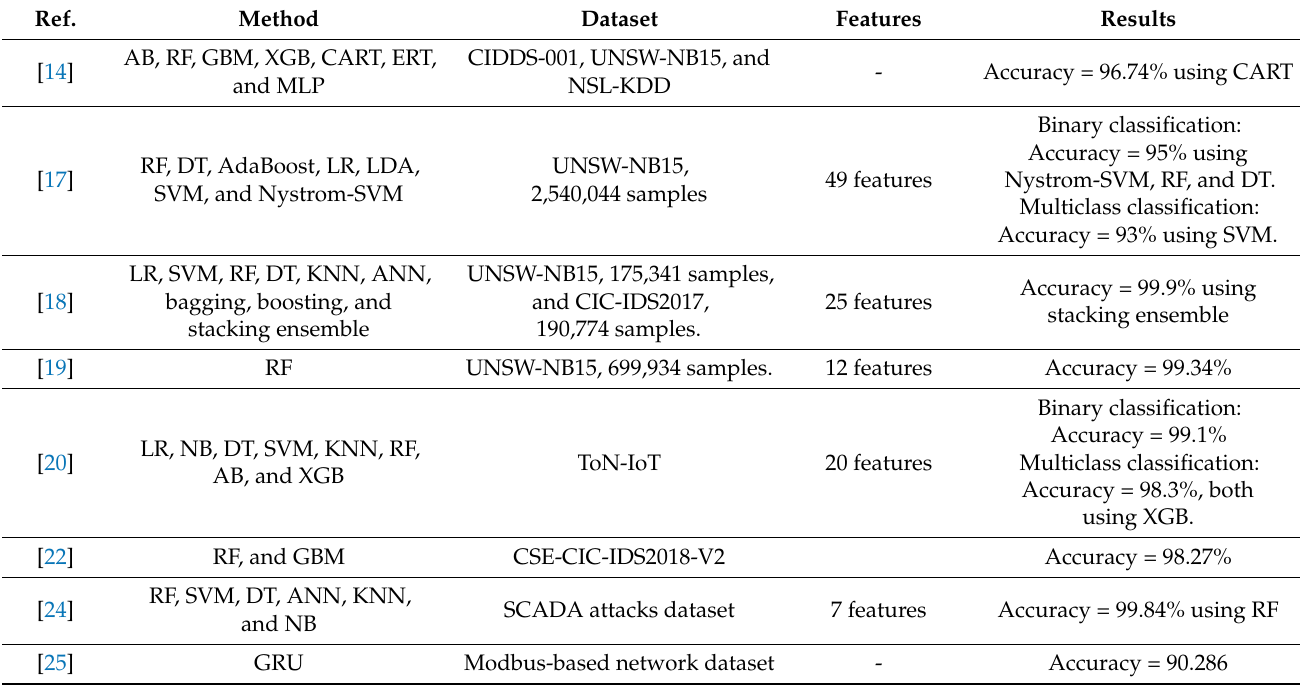
Table 1. Literature review